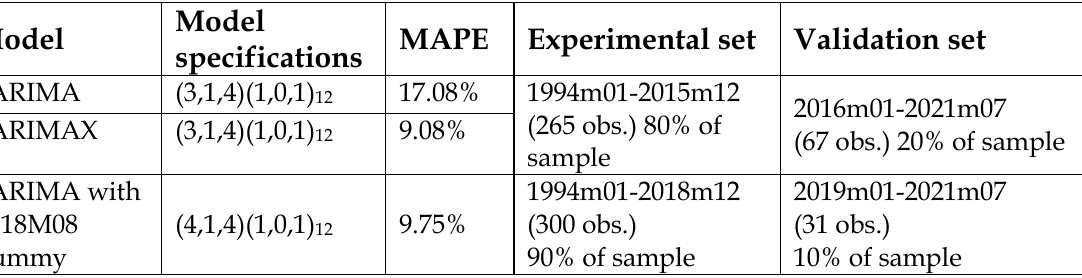
Table 5. The model identification and forecasting